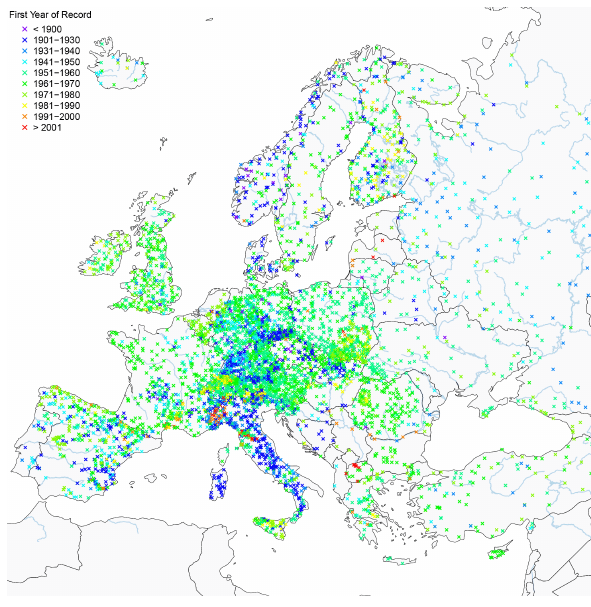
Figure 4. Catchment area [km 2 ].